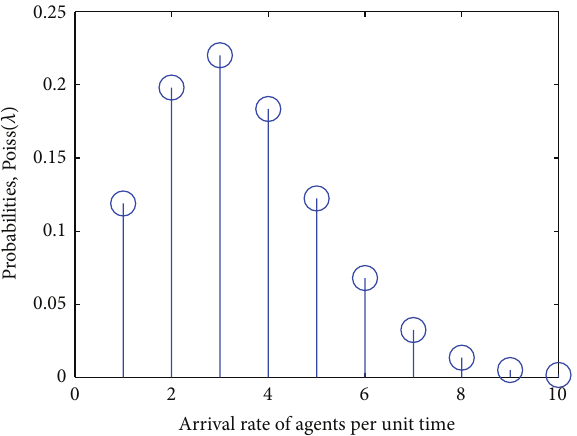
Figure 2: Distribution of agents arriving at strawberry plants to eat fruit and disperse seeds.